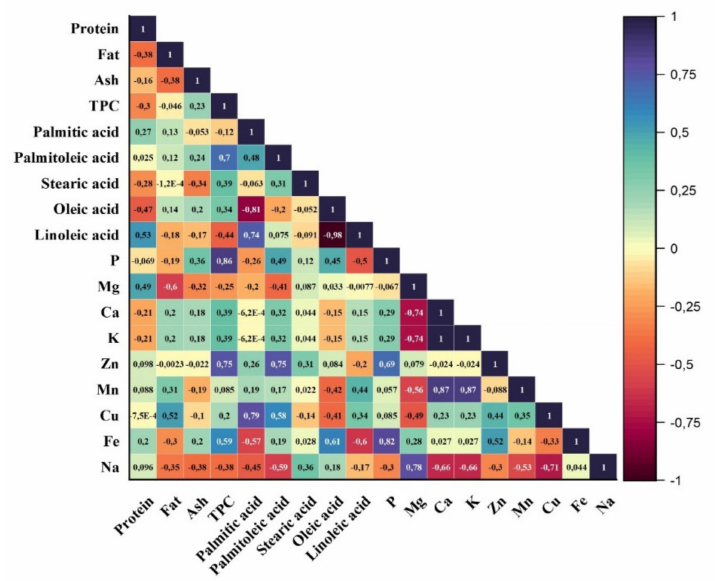
Figure 1. Pearson correlation matrix of almond characteristics.